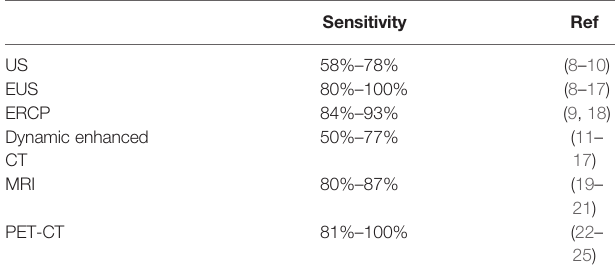
TABLE 1 | The ability of various imaging techniques to detect early-stage pancreatic carcinoma with a tumor diameter of less than 2 cm.